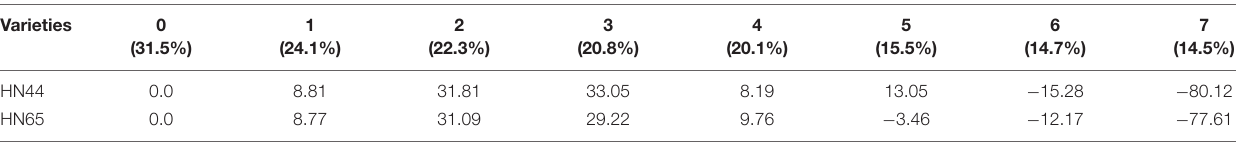
FIGURE 5 | Effect on POD activity under different soil water contents. Indicates that the values marked with different letters are significantly different, and those marked with the same letter are considered to be statistically insignificant. TABLE 6 | Effect of drought on the relative growth rate of POD activity (%).